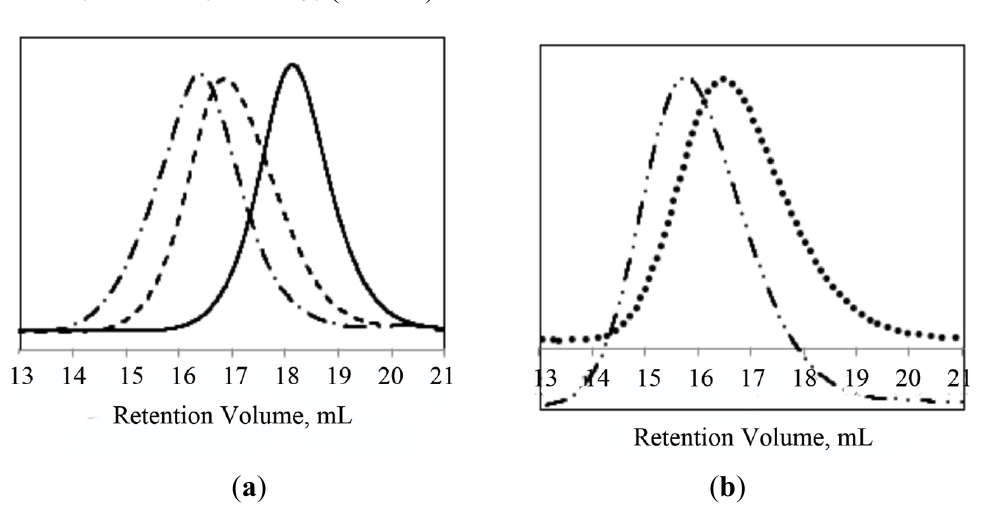
macroinitiator (─), PNIPAAm 58